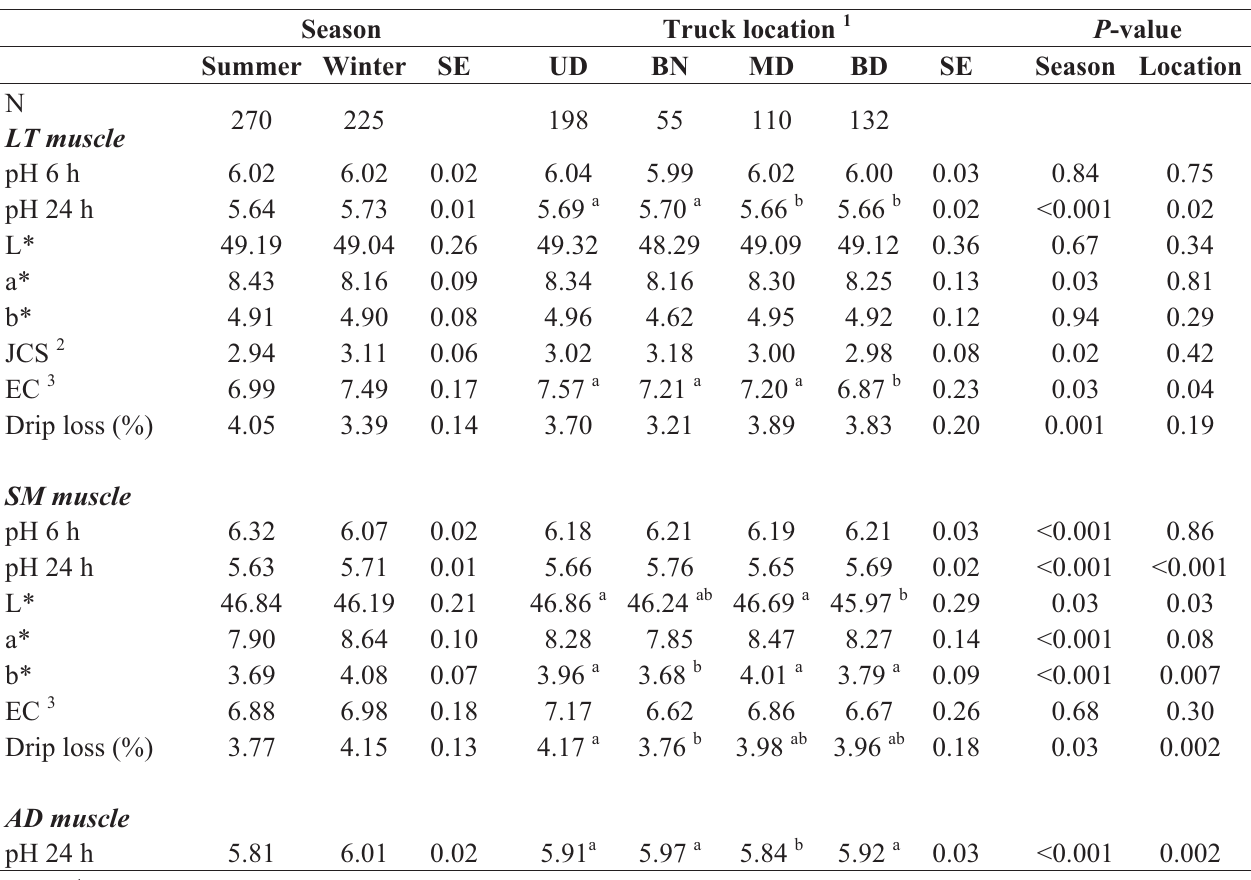
Table 5. Meat quality variation as measured in the Longissimus thoracis (LT), Semimembranosus (SM ) and Adductor (AD) muscles of pigs transported on a PB trailer according to the season and the truck